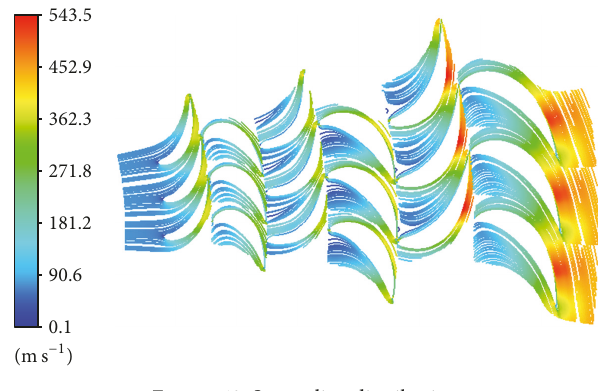
Figure 13: Streamline distribution.